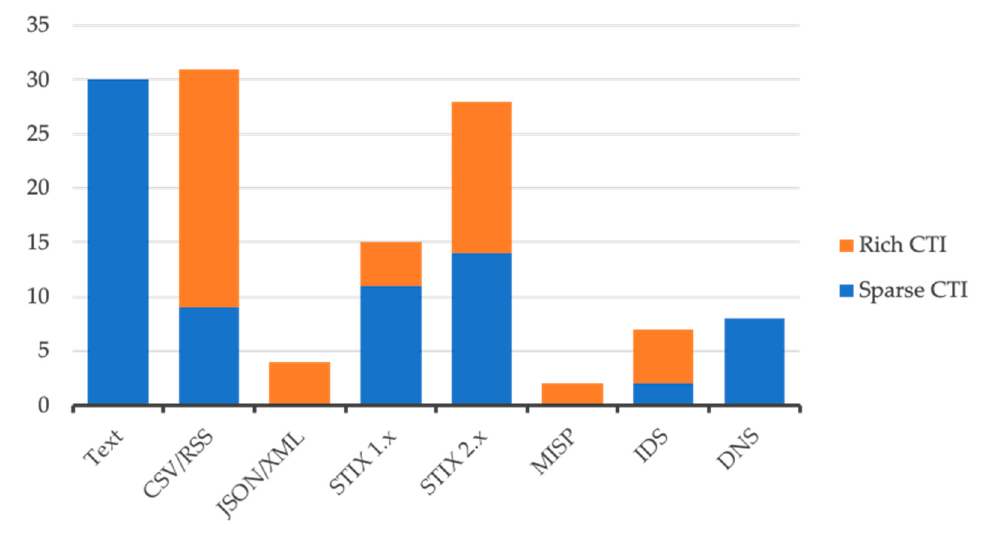
Figure 3 . Rich vs. sparse CTI . Figure 3. Rich vs. sparse